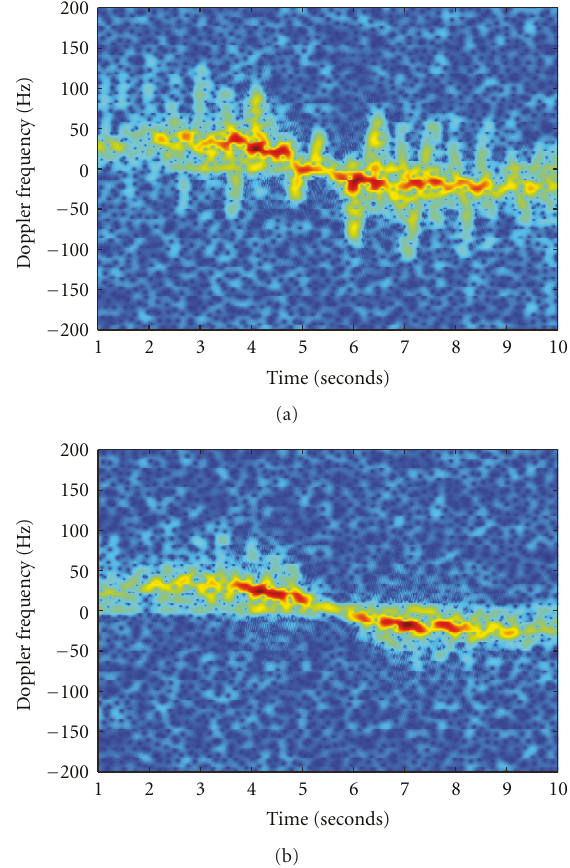
Figure 13: Spectrograms of two-arms and no-arms motions captured at 30 degree incidence angle.